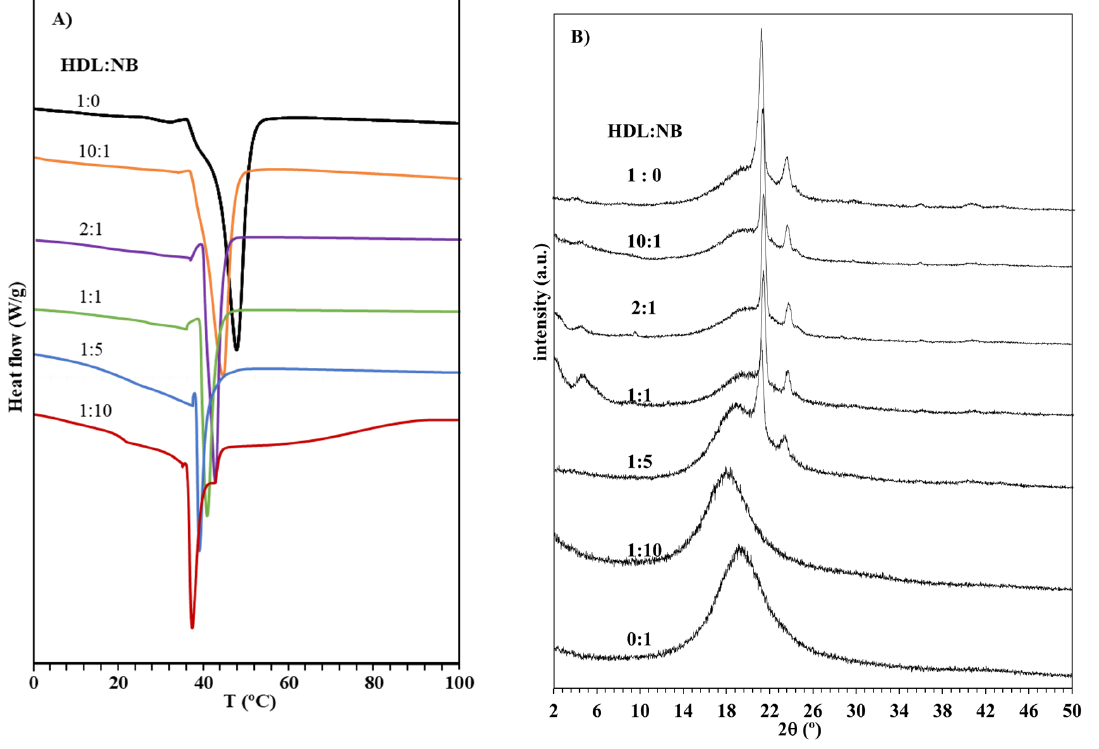
Figure 3. ( A ) Second-heat thermograms of DSC and ( B ) X-ray diffraction pattern of PHD, PNB, and HDL-NB copolymers (from 10:1 to 1:10). Table 4. Thermal and mechanical properties of the copolymerization via ROMP of ω -6- hexadecenlactone (HDL) with norbornene